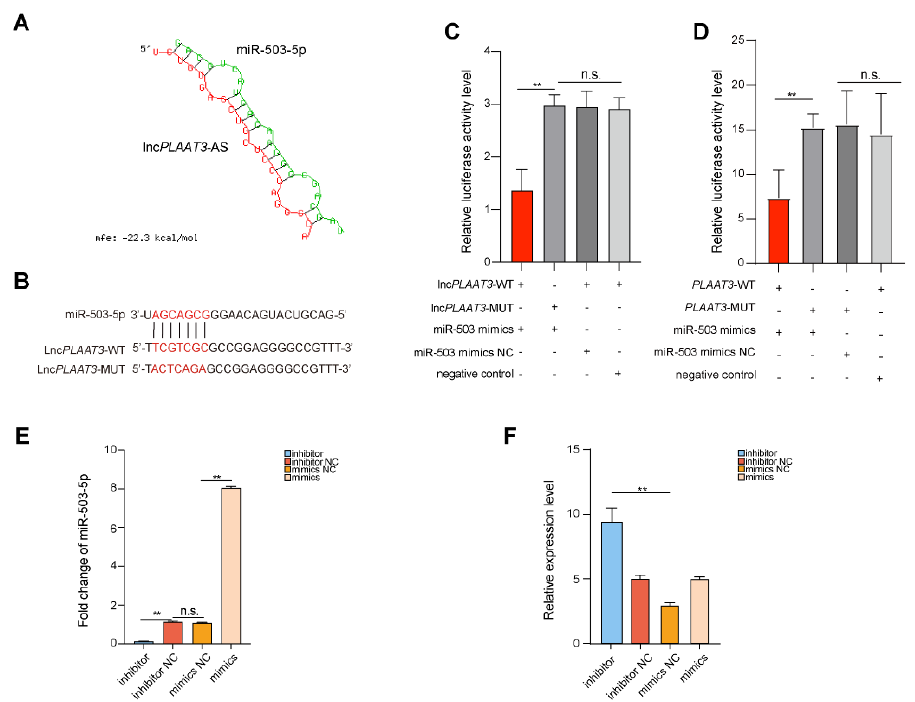
Figure 3. ( A ) Predicted miR-503-5p binding site in lnc PLAAT3 -AS as determined by RNAhybrid; ( B ) binding capacity of lnc PLAAT3 -AS and miR-503-5p as evaluated by RNAhybrid (Red sequences are miRNA seed region binding sequences); ( C ) luciferase assay revealed miR-503-5p-mediated inhibition of lnc PLAAT3 -AS activity, miR-503-5p mimics NC is miR-503-5p mimics negative control ("+" indicates transfected, " − " indicates not transfected); ( D ) luciferase assay revealed miR-503-5p–mediated inhibition of PLAAT3 activity; ( E ) Transfection efficiency as measured by qRT-PCR, miR-503-5p inhibitor NC is miR-503-5p inhibitor negative control; ( F ) qRT-PCR analysis of PLAAT3 expression in transfected cells. All results are presented as means ± SEM; n = 3; ** p < 0.01; n.s., no significant difference.